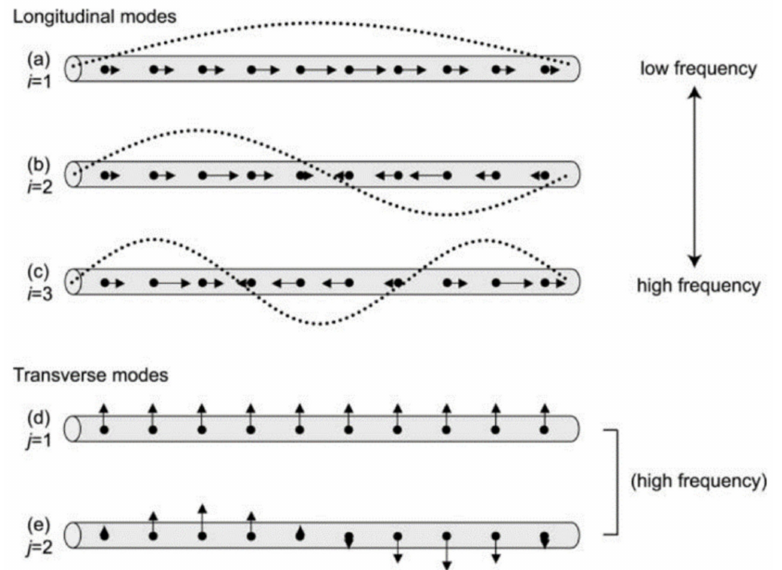
Figure 6. Fundamental and high-order LSPR longitudinal and transversal modes on NRs. Repro- duced with permission from [158].